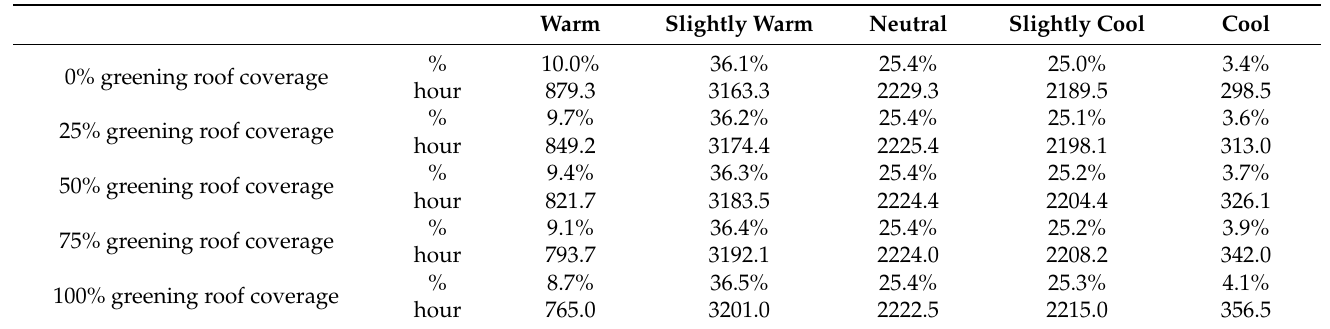
Table 5. Durations of indoor thermal perceptions of different roof greening coverages. Warm Slightly Warm Neutral Slightly Cool Cool % 0% greening roof coverage